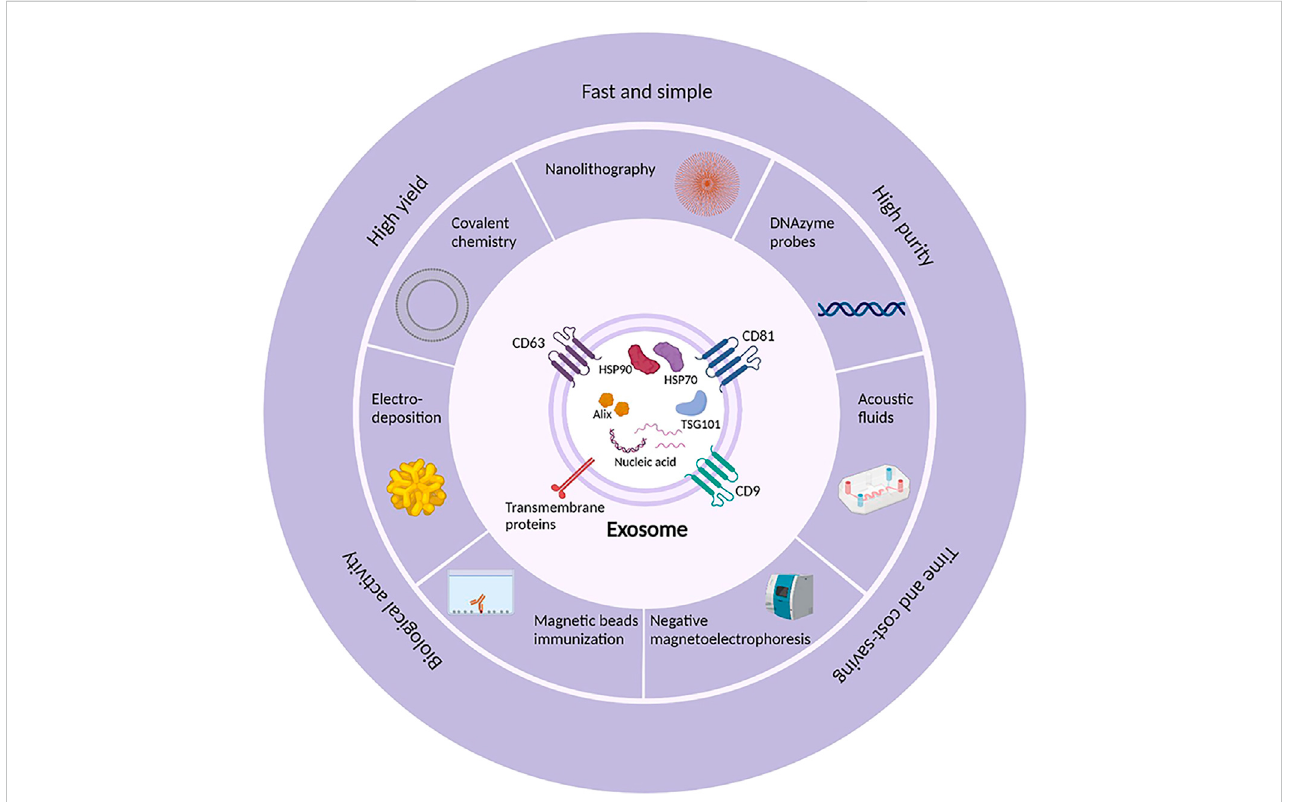
FIGURE 1 The emerging isolation methods and technologies and the hallmarkers of exosomes. Exosomes are usually found to express markers like CD63, CD81, CD9, HSP70, HSP90, TSG101, and Alix. Currently, exosomes can be isolated by a variety of methods and technologies such as nanolithography, electro- deposition, immunomagnetic beads, covalent chemistry, DNAzyme probes, and negative magneticelectrophoresis to achieve the isolation ef fi ciency of simple and rapid, high yield and purity, time and